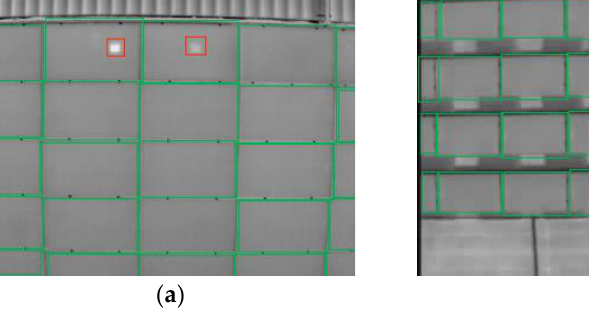
Table 1. Infrared photovoltaic image dataset. Dataset Pictures Panels